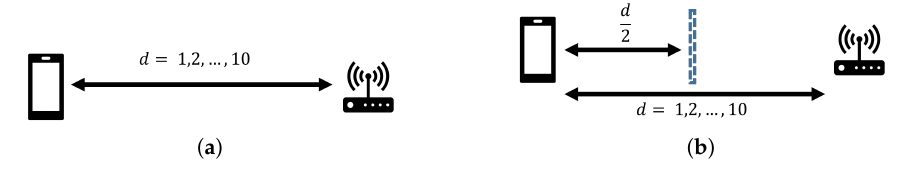
Figure 4. Schematic of the RFPF environment: ( a ) LOS condition; ( b ) NLOS condition.